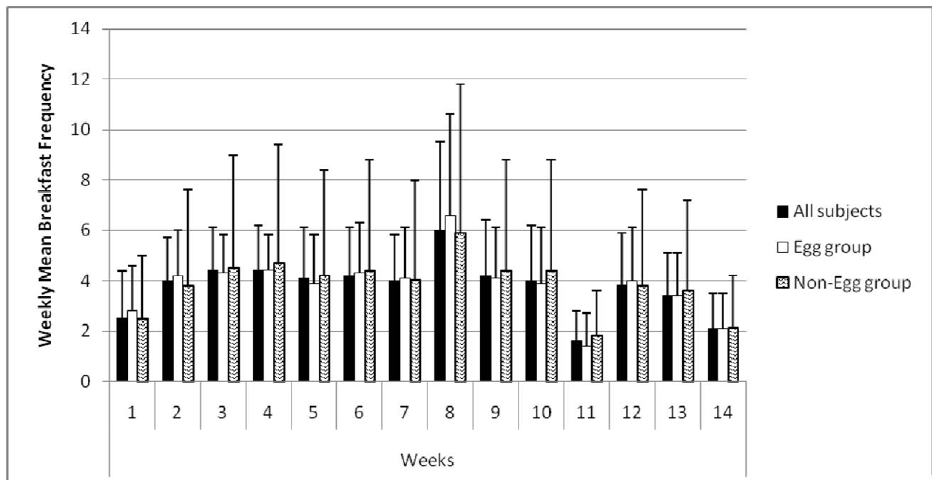
Figure 2. Time course of breakfast